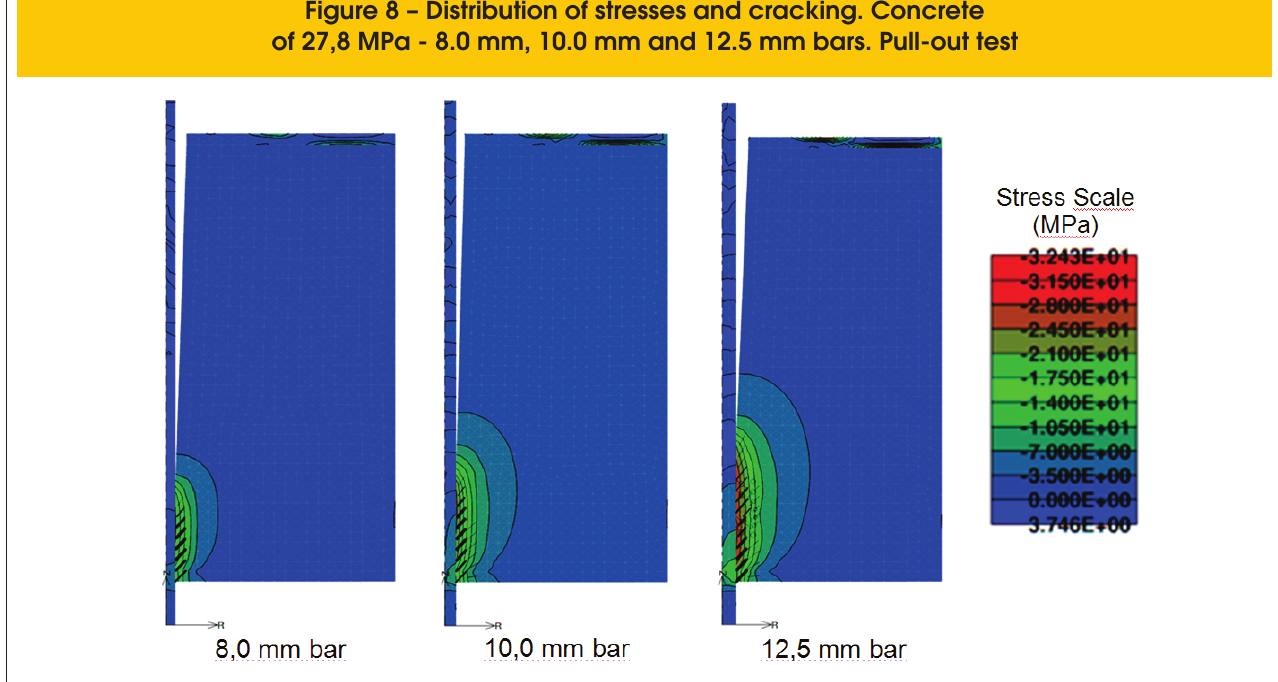
Figure 8 – Distribution of stresses and cracking.